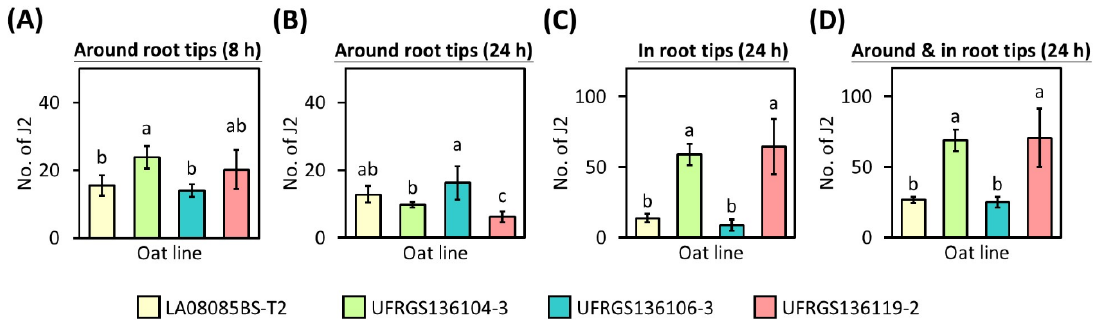
Figure 1. Numbers of M. graminicola J2 in a 1 mm diameter area around the root tips and in the roots of oat lines at 8 h and 24 h after inoculation: ( A ) Number of J2 around the oat root tips at 8 h after inoculation, ( B ) number of J2 around the oat root tips at 24 h after inoculation, ( C ) number of J2 in the oat roots at 24 h after inoculation, and ( D ) total number of J2 around the oat root tips and inside the oat roots after 24 h. Data points are mean ± standard error (SE) of 5 replicates. Means followed by the same letter are not significantly different ( P ≥ 0.05).